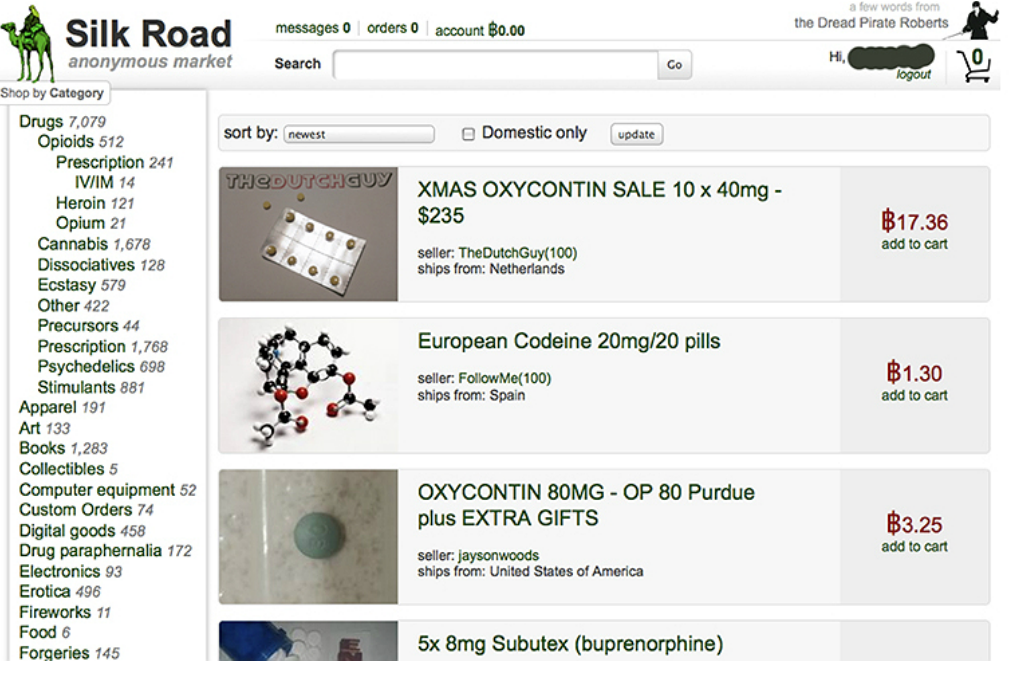
Figure 2. Screenshot of Silk Road - an anonymous online marketplace where drugs, fireworks, and stolen goods are